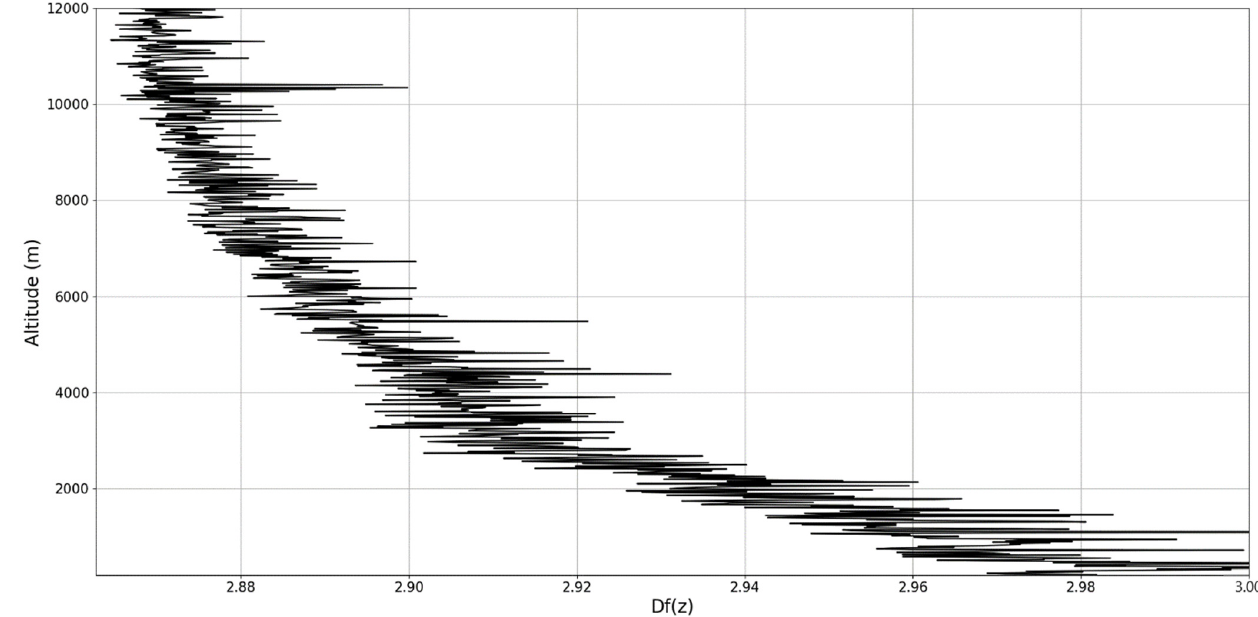
Figure 21. D (cid:2890) profile, λ = 1064 nm , Gala ț i, Romania, 22 December 2021. Figure 21. D λ = 1064 nm, Galat F profile,